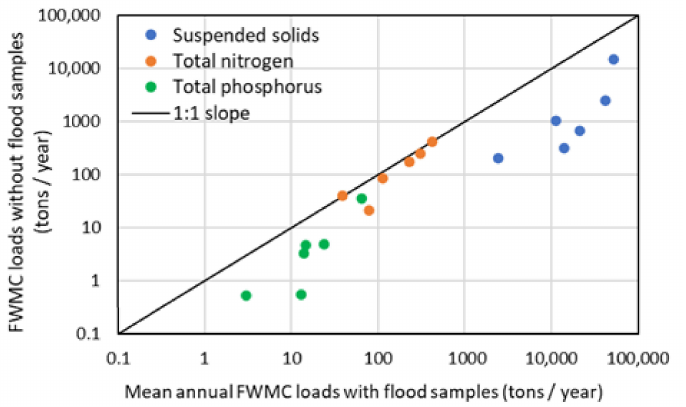
Figure 17. Comparison of the mean annual loads calculated for the six watersheds using the FWMC method with or without the flood samples (plotted on a log scale).